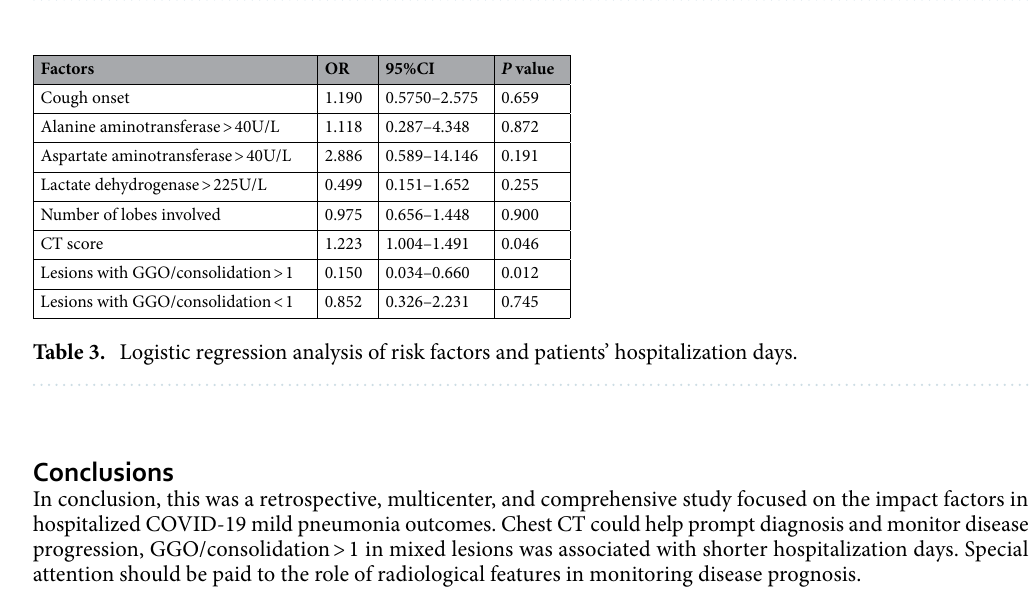
Figure 5. Example of patients with CT demonstrated as consolidation > GGO component in Group 2. ( A ) 29-year-old female confirmed with COVID-19 pneumonia in Group 2 who had hospitalization days of 19 days. CT images demonstrated multiple lesions with mixed density which were predominantly solid components (arrows). ( B ) 28-year-old male in Group 2 with hospitalization days of 19 days. CT images also demonstrated multiple mixed density lesions with predominantly solid components (arrows).